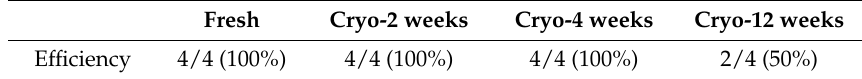
Figure 2. Adipogenic differentiation in ASCs. Fresh or cryopreserved adipose-derived stem/stromal cells (Fresh- or Cryo-ASCs) were differentiated into adipocytes (as described in the Materials and Methods section). Adipogenesis was revealed by Oil red O staining for lipid droplets. (−): confluent state without adipogenic induction; (+): 28 days after adipogenic induction. Table 1. Efficiency of adipogenic differentiation.